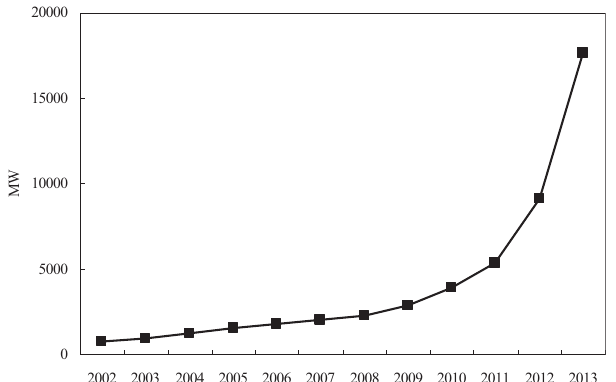
Fig. 1. Cumulative PV capacity in Japan. Data : Japan ’ s Energy White Paper 2015 [1].